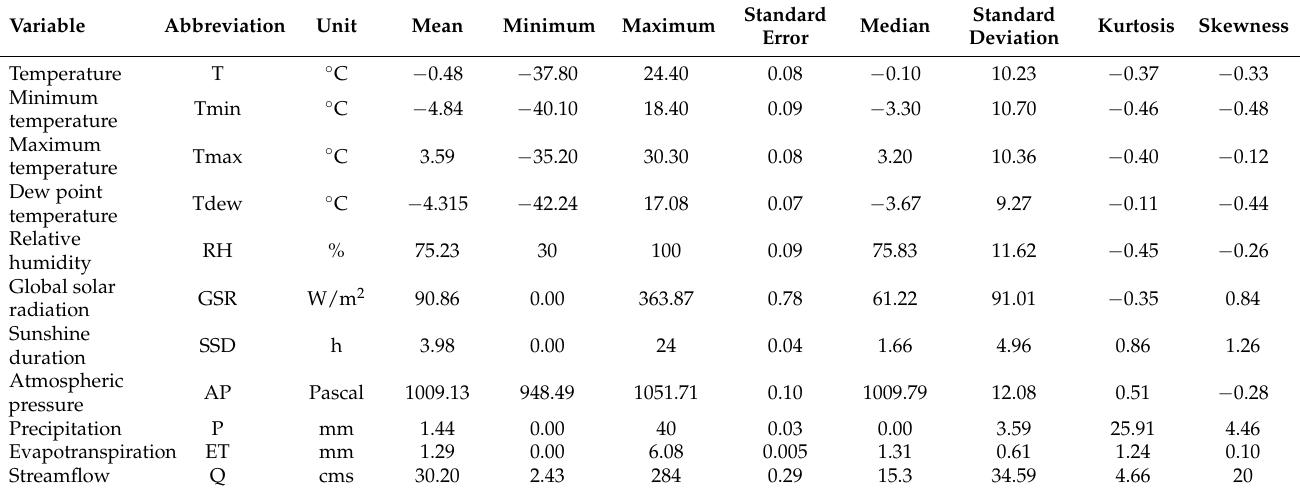
Figure 1. Location of the Kalixälven river basin in northern Sweden. Table 1. Statistical characteristics of atmospheric and streamflow